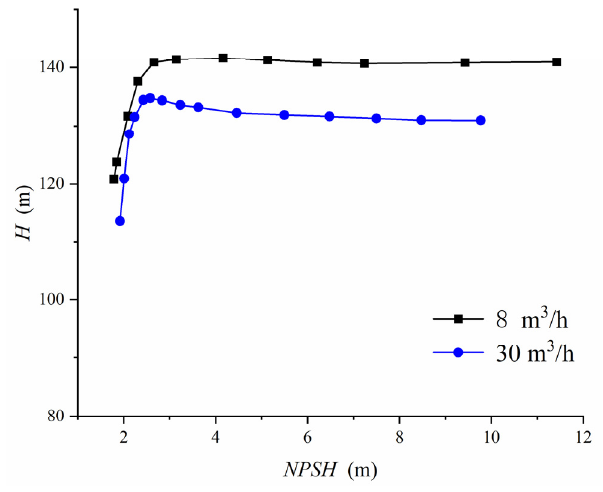
Figure 13. Cavitation performance curve of a high-speed magnetic